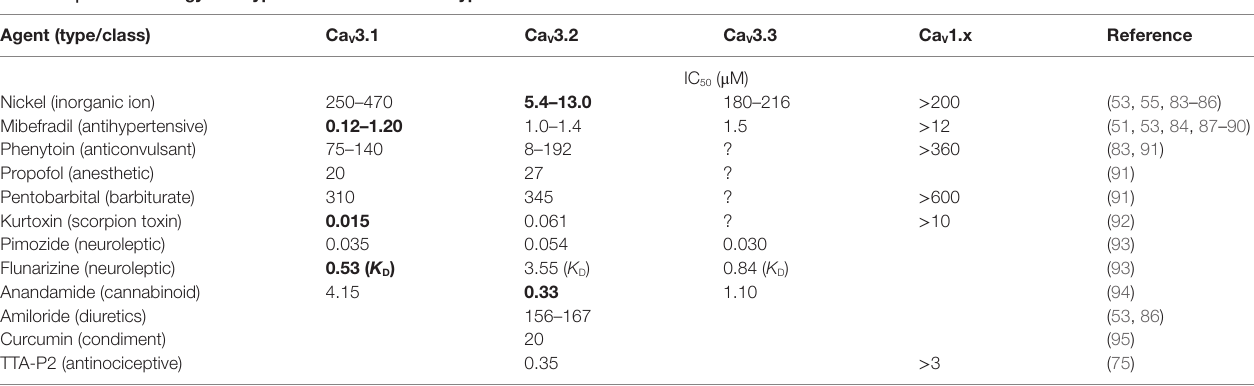
TABLe 4 | Pharmacology of T-type calcium channel isotypes.